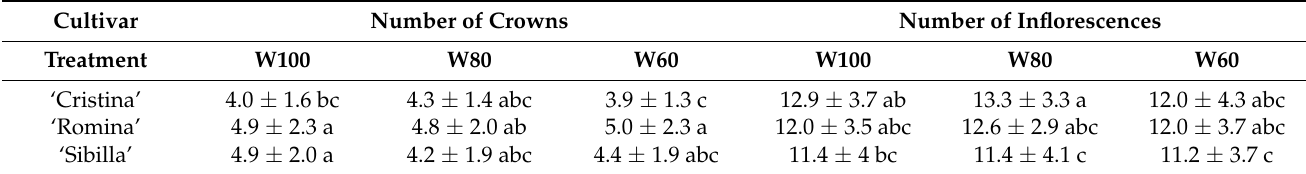
Table 8. Effects of water availability on branch crowns number and inflorescences number in different strawberry cultivars. Values with the same lowercase letter for the same parameter were not statistically different for Fisher’s LSD test ( p < 0.05). Values are expressed as means of two